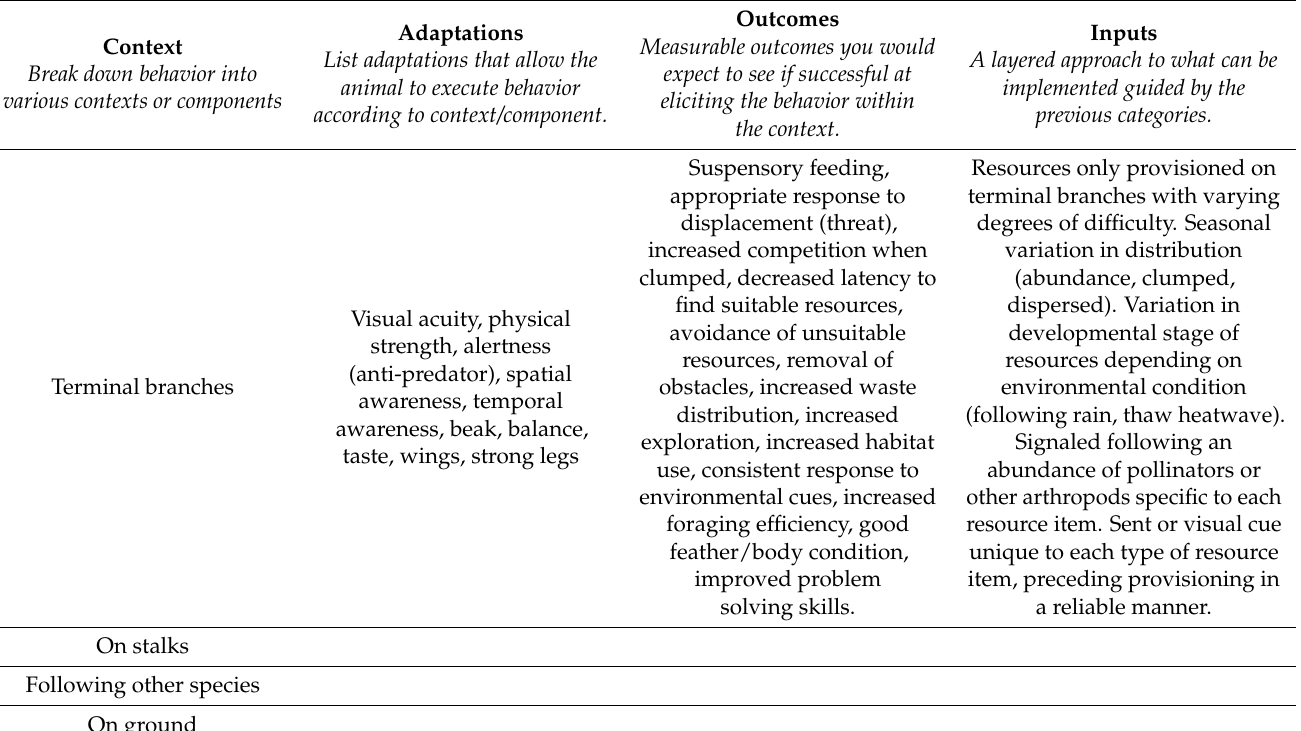
Table 1. Species—Corvid, Behavior—Foraging (consider as a